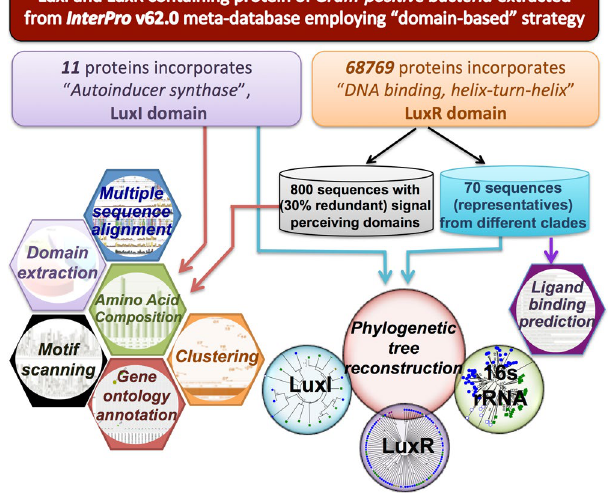
Figure 1. A flowchart depicting the amount of LuxI and LuxR containing proteins used in various analyses in the